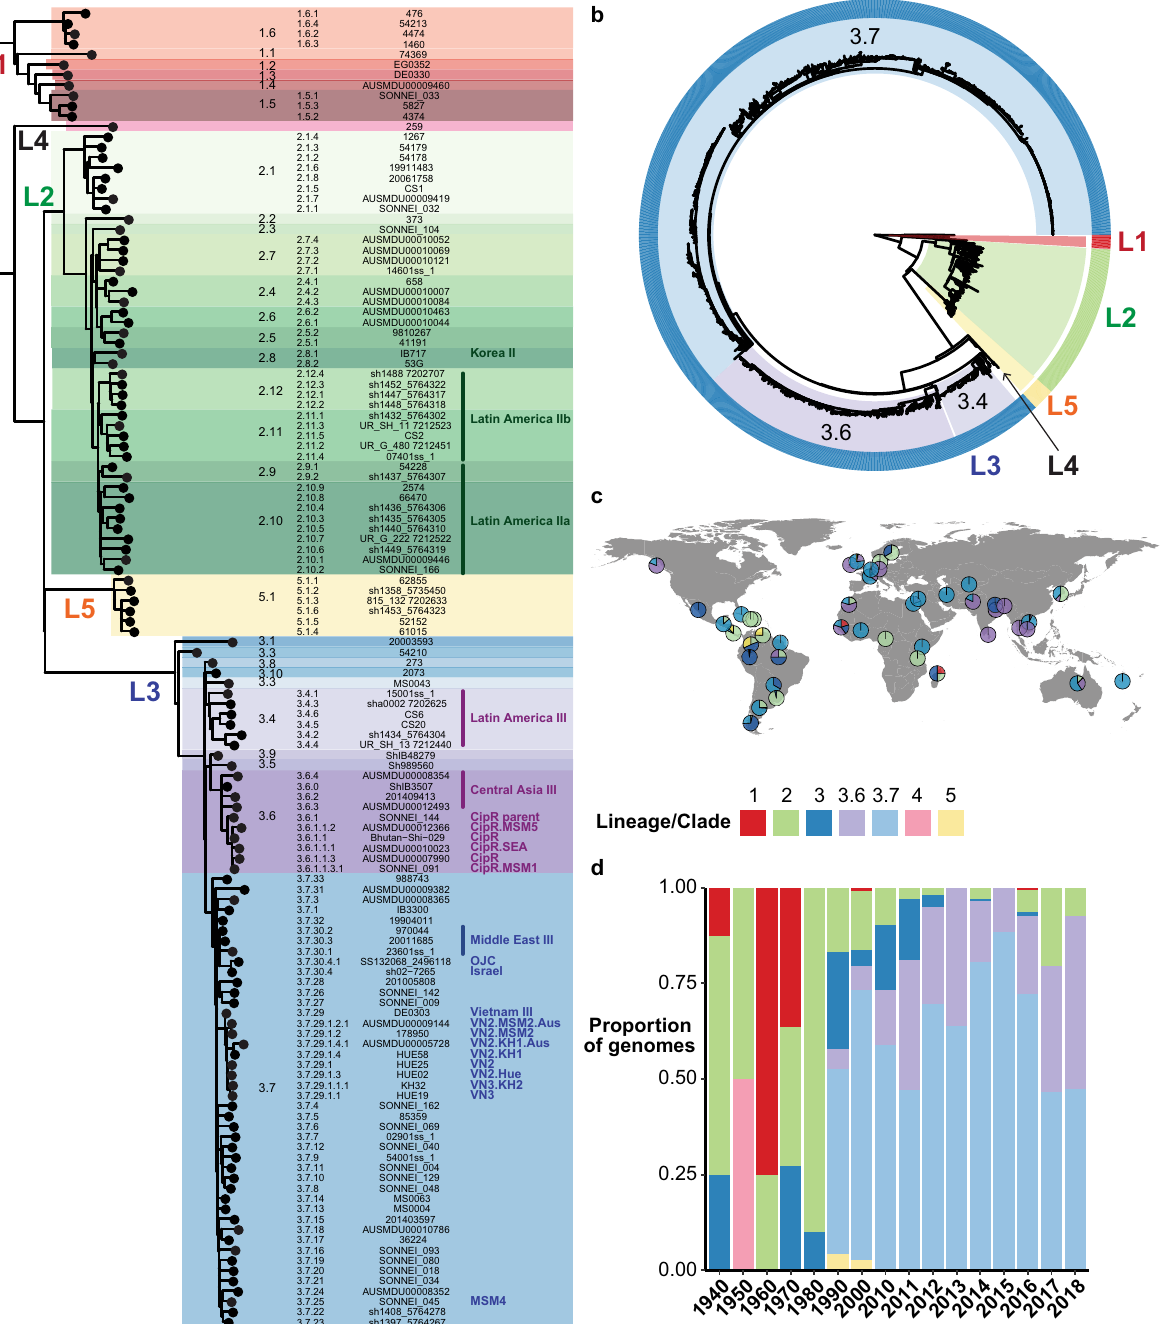
Fig. 1 Population structure, temporal distribution and geographic distribution of the 1935 S. sonnei genomes in the discovery set. a Maximum likelihood phylogeny (outgroup rooted using E. coli ) of one representative per genotype. Lineages are labelled L X , where X is the lineage number. Highlighting and column 1 indicate clades, column 2 indicates genotype, column 3 shows strain names, column 4 shows human readable genotype names (for epidemiological groups noted in Table 2). b Maximum likelihood phylogeny (outgroup rooted using E. coli ), c frequencies by geographic region, and d frequencies by decade/year; for all discovery set genomes and coloured by lineage and major clades (3.6, 3.7, see inset legend). Interactive version of linked phylogeny, map and timeline for this data set are available online in Microreact (https://microreact.org/project/fG2N7huk9oZNCaVHu8rukr).